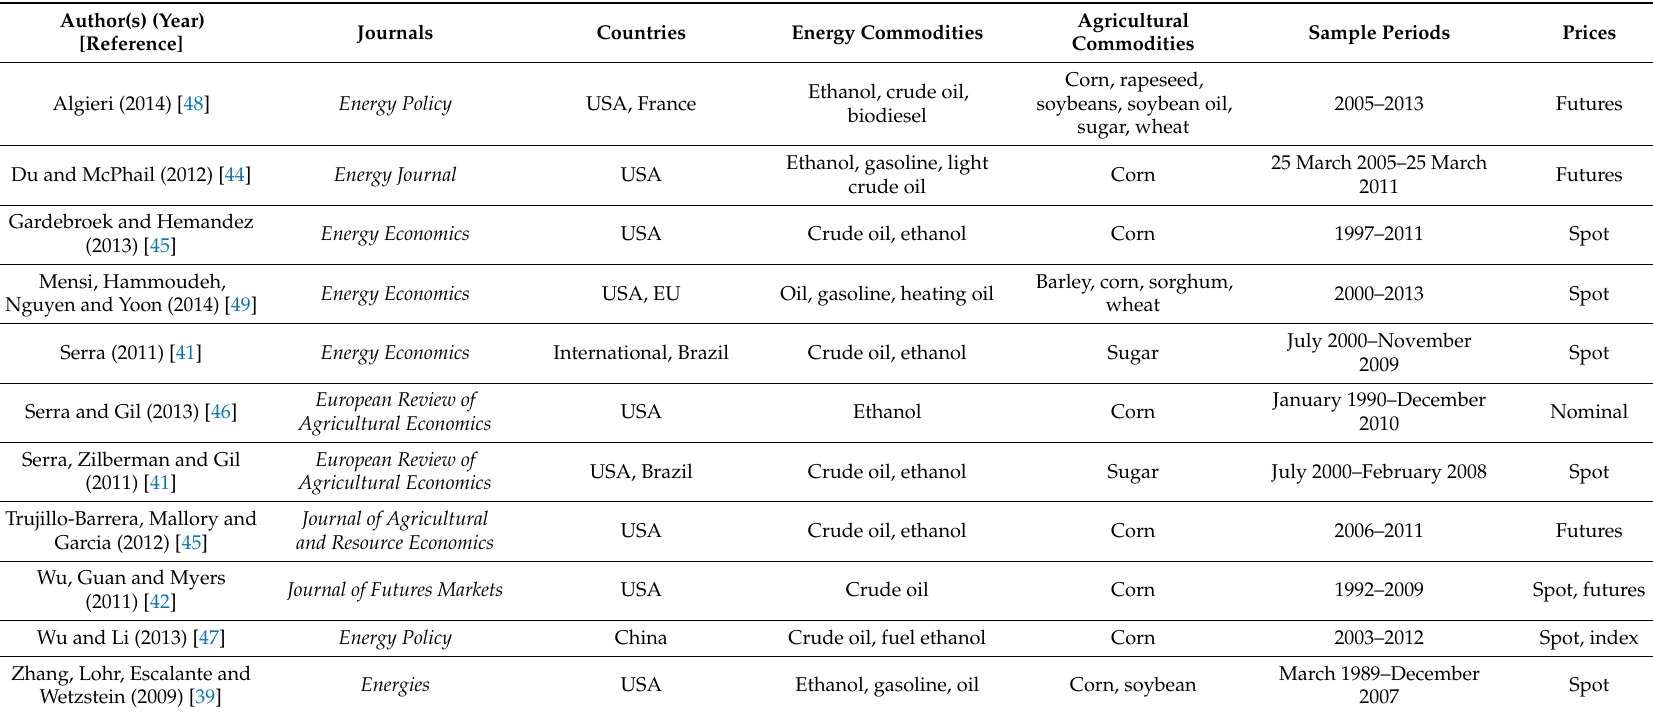
Table 1. Summary of Literature on Volatility between Energy and Agricultural Markets using Baba, Engle, Kraft, and Kroner (BEKK) and dynamic conditional correlation